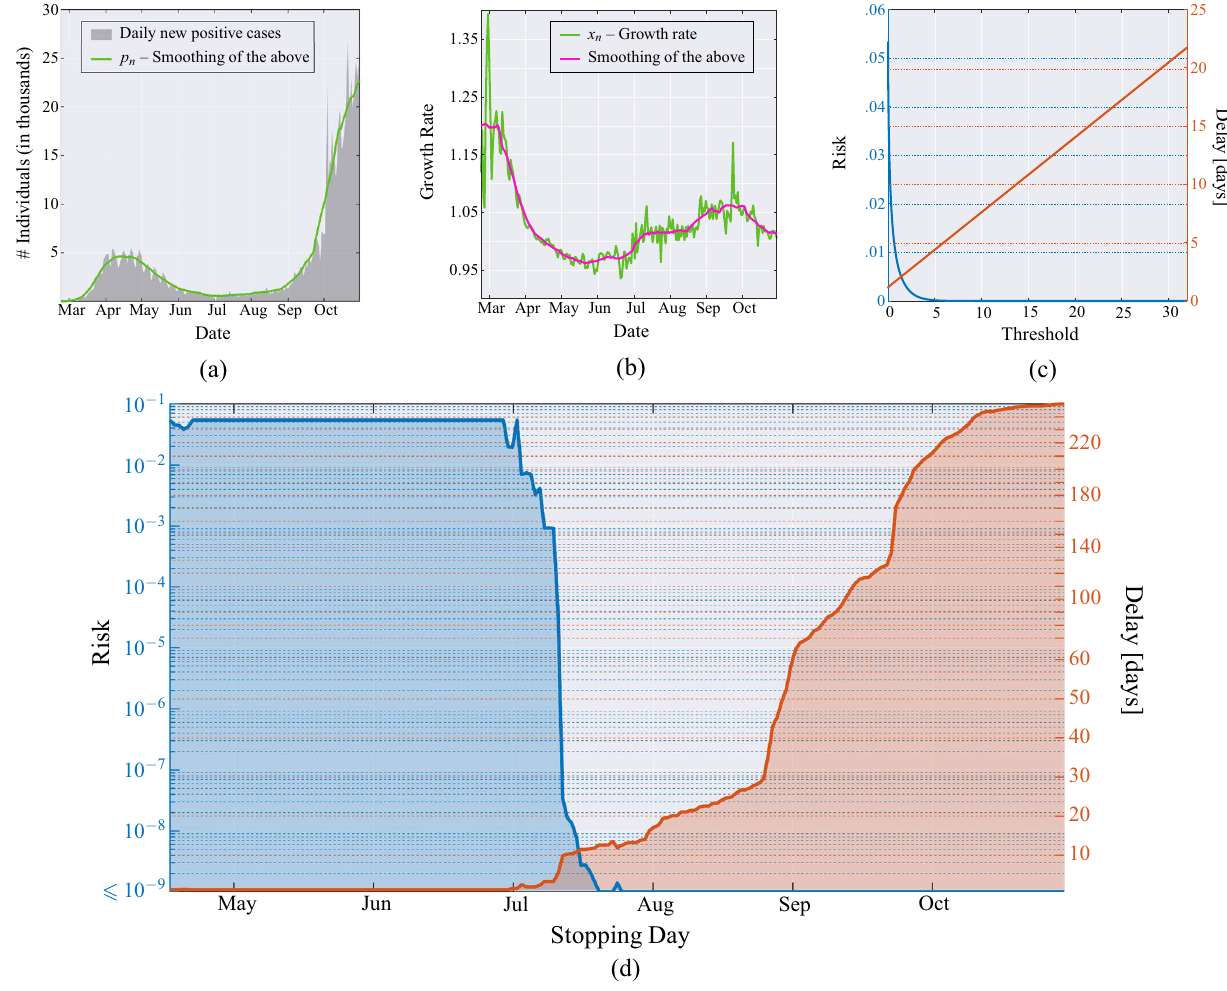
Figure 8. United Kingdom. ( a ) Daily new positive individuals in the UK since February 23, 2020, and its moving average obtained with a window of 21 days (green line). ( b ) Growth rate of the epidemic computed from the averaged daily new positive cases (green line), and its time-varying mean obtained through a moving average that uses a window of 21 days (magenta line). ( c ) MAST performance, in terms of risk (left axis) versus threshold and mean delay (right axis) versus threshold, obtained from the UK data of the COVID-19 pandemic. ( d ) Application of the MAST procedure on the COVID-19 pandemic data from UK. On the left-side vertical axis, we select a desired risk, e.g., R = 10 − 4 . Then, the blue curve indicates the stopping day (about July 11, in the example) corresponding to the selected value of risk. Finally, the red curve referred to the right-side vertical axis shows the mean delay (cid:31) corresponding to the selected risk R (below 6 days). For clarity, note that the right- side scale for the delay is split into two linear ranges, for a better rendering of the small- (cid:31)